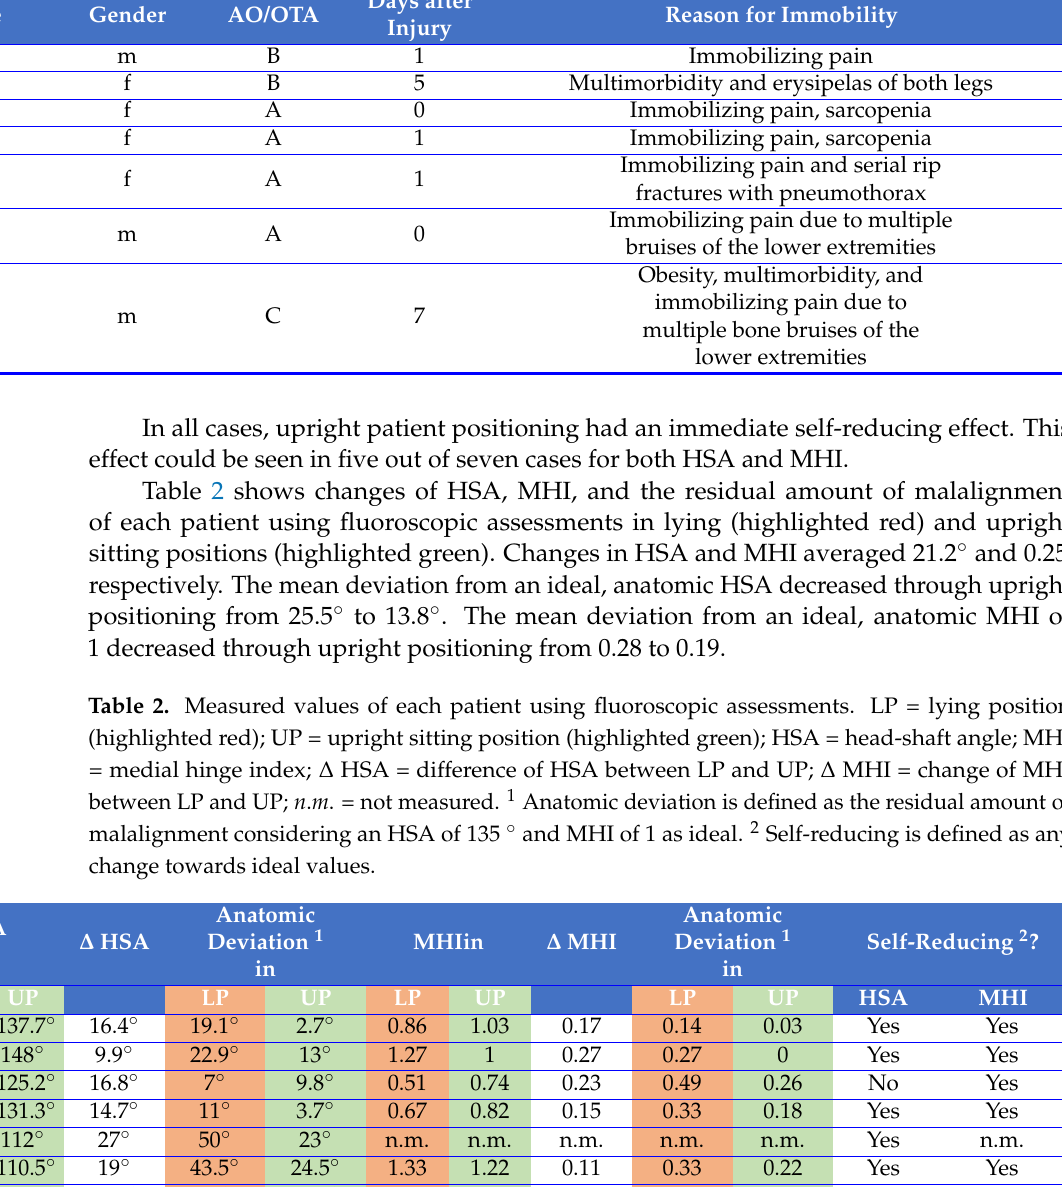
Table 1. Details about age, gender, reasons for immobility, and fracture type of each patient. Patientno.